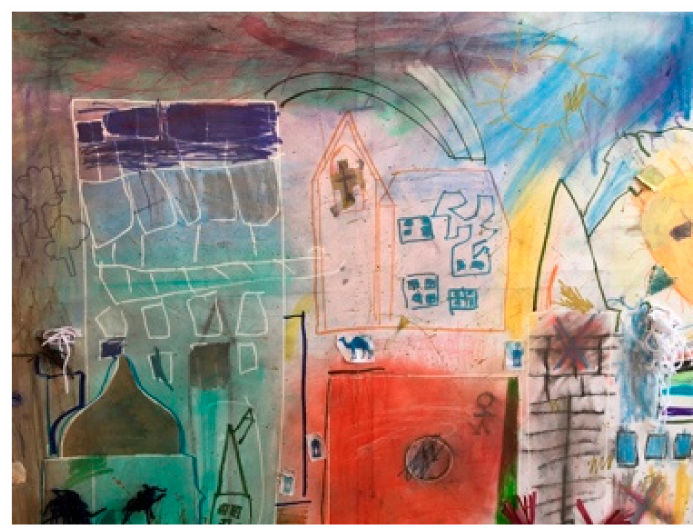
Figure 2. Future city, example one from a northern English Primary School, 2018. This image features a mosque, a church and two high-density housing estates. RMIT University Human Ethics Clearance Number 21071.